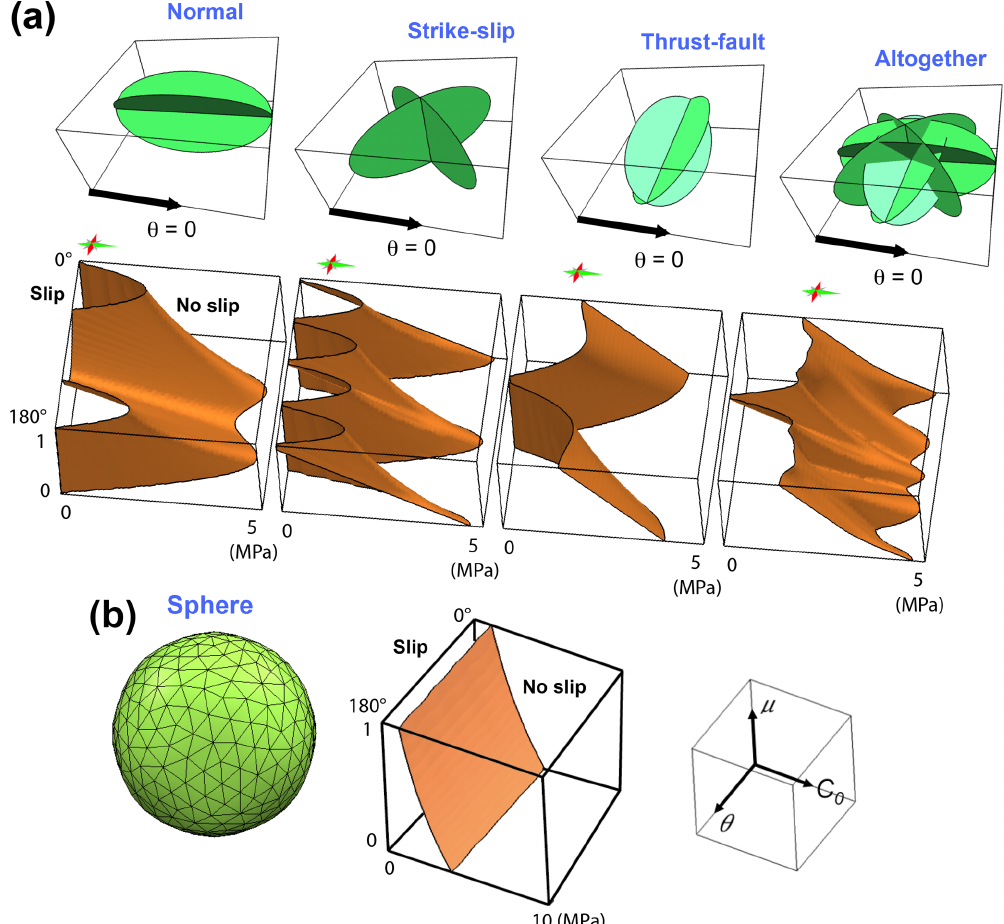
Figure 2. Synthetic 3-D fault geometries and their fault slip envelopes. (a) Variable 3-D intersecting fault geometries and related fault slip envelope calculated with the same variables as Fig. 1. (b) Theoretical case of a sphere and its fault slip envelope calculated with the same variables as (a) and Fig. 1. The small empty box indicates the parameters on each axis of the envelope diagrams shown in panels (a) and (b) .